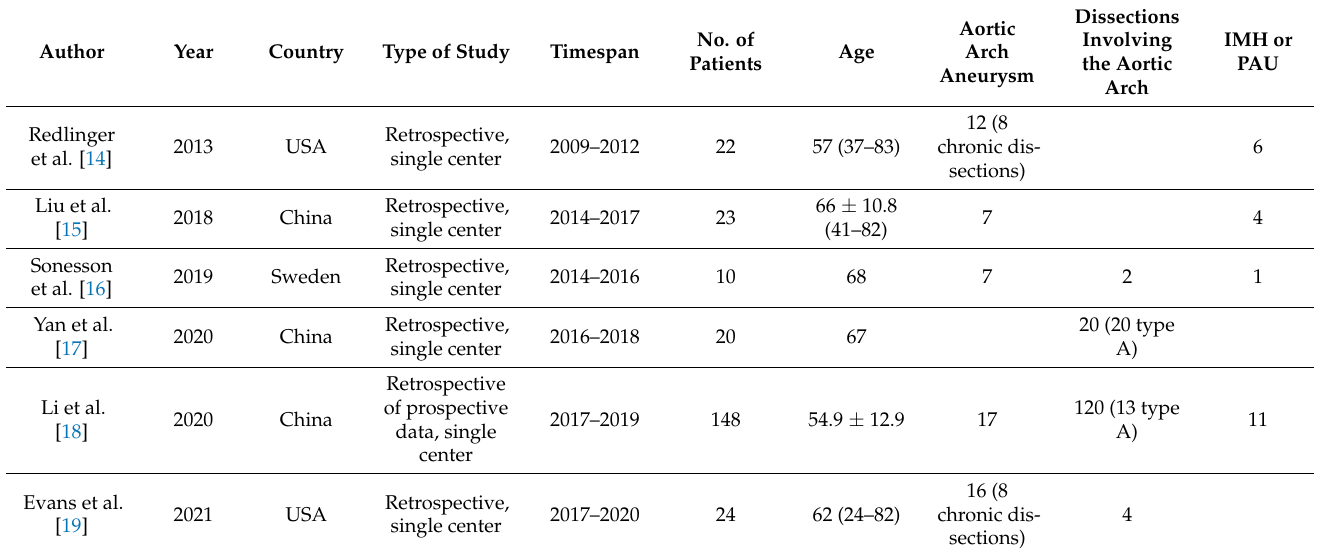
Table 1. The main characteristics of the included studies and indications to